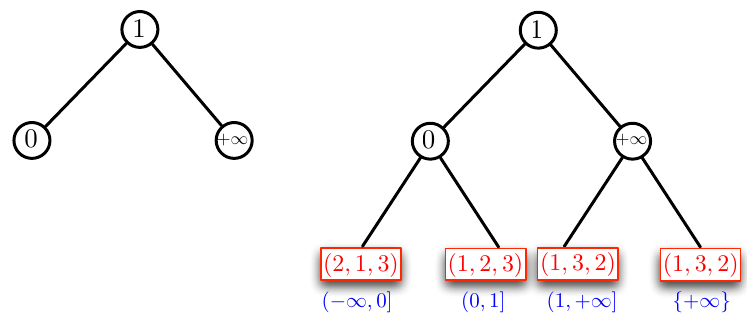
Figure 4. The AVL tree for the slopes 0 < 1 < + ∞ ( left ) and the corresponding structure L ( P ) ( right ) for the set P of Example 2. The blue intervals indicate the slope set covered by a leaf.